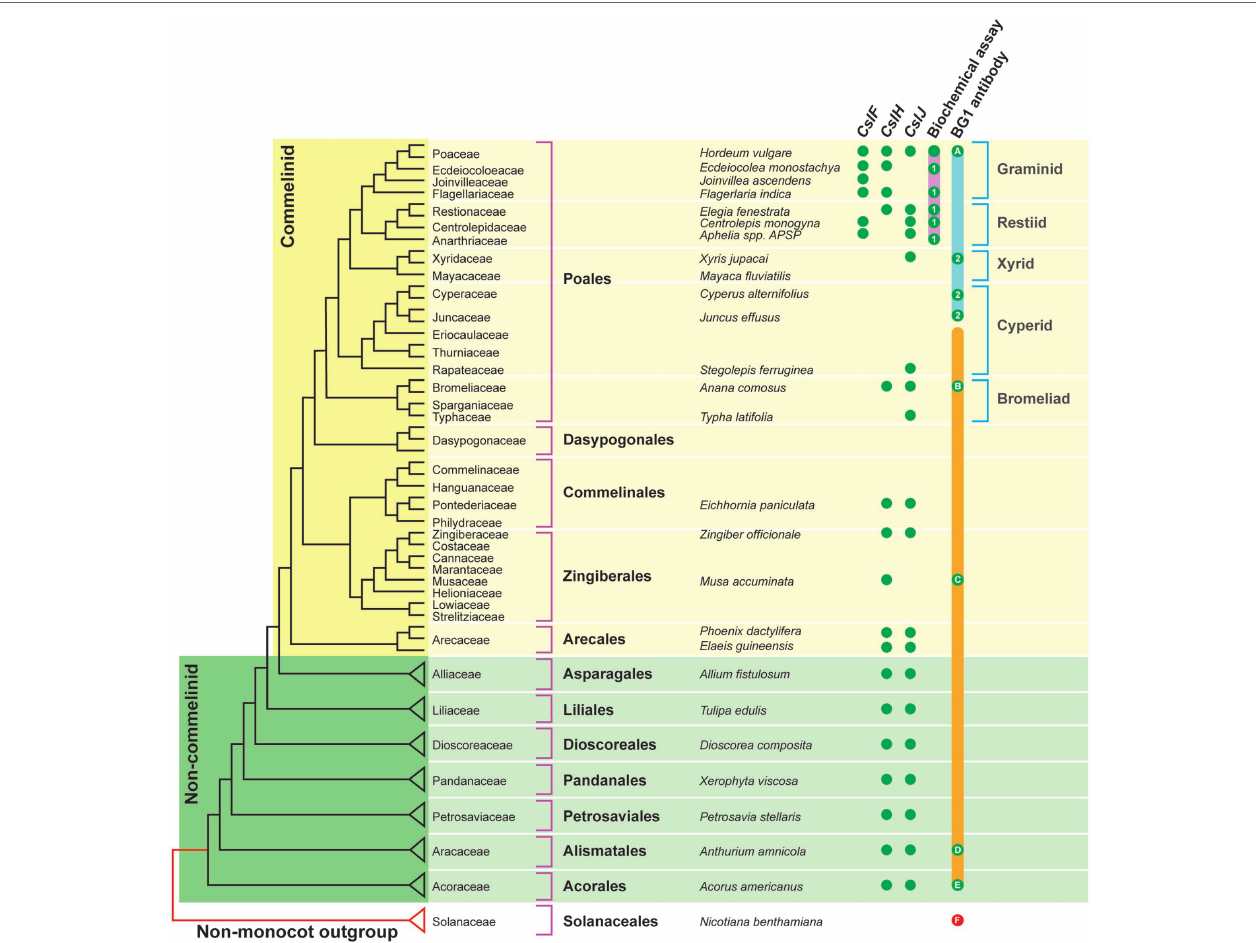
FIGURE 3 | Distribution of (1,3;1,4)- β -glucans in commelinid and noncommelinid species of the monocots. The figure is reproduced from Little et al. (2018) and is based on a species tree adapted from McKain et al. (2016). The orange bar represents species where one would expect (1,3;1,4)- β -glucan antibody labeling based on the presence of CslH or CslJ . Green dots indicate confirmed antibody labeling; red dots are negative. The pink bar shows species that are predicted to contain (1,3;1,4)- β -glucan as detected with the biochemical assay; actual positives are highlighted using green dots. Green dots labeled 1 are the results of Smith and Harris (1999). The solid blue bar indicates species that are predicted to contain (1,3;1,4)- β -glucan detectable with the BG1 antibody, with actual positives highlighted with green dots. Green dots labeled 2 indicate positive results from Trethewey et al. (2005). The solid orange bar indicates the range of species that are predicted to contain (1,3;1,4)- β -glucan detectable with the BG1 antibody, with positives highlighted using green dots. It should be noted that the Poaceae family lies within the graminid clade. Reproduced from Little et al.